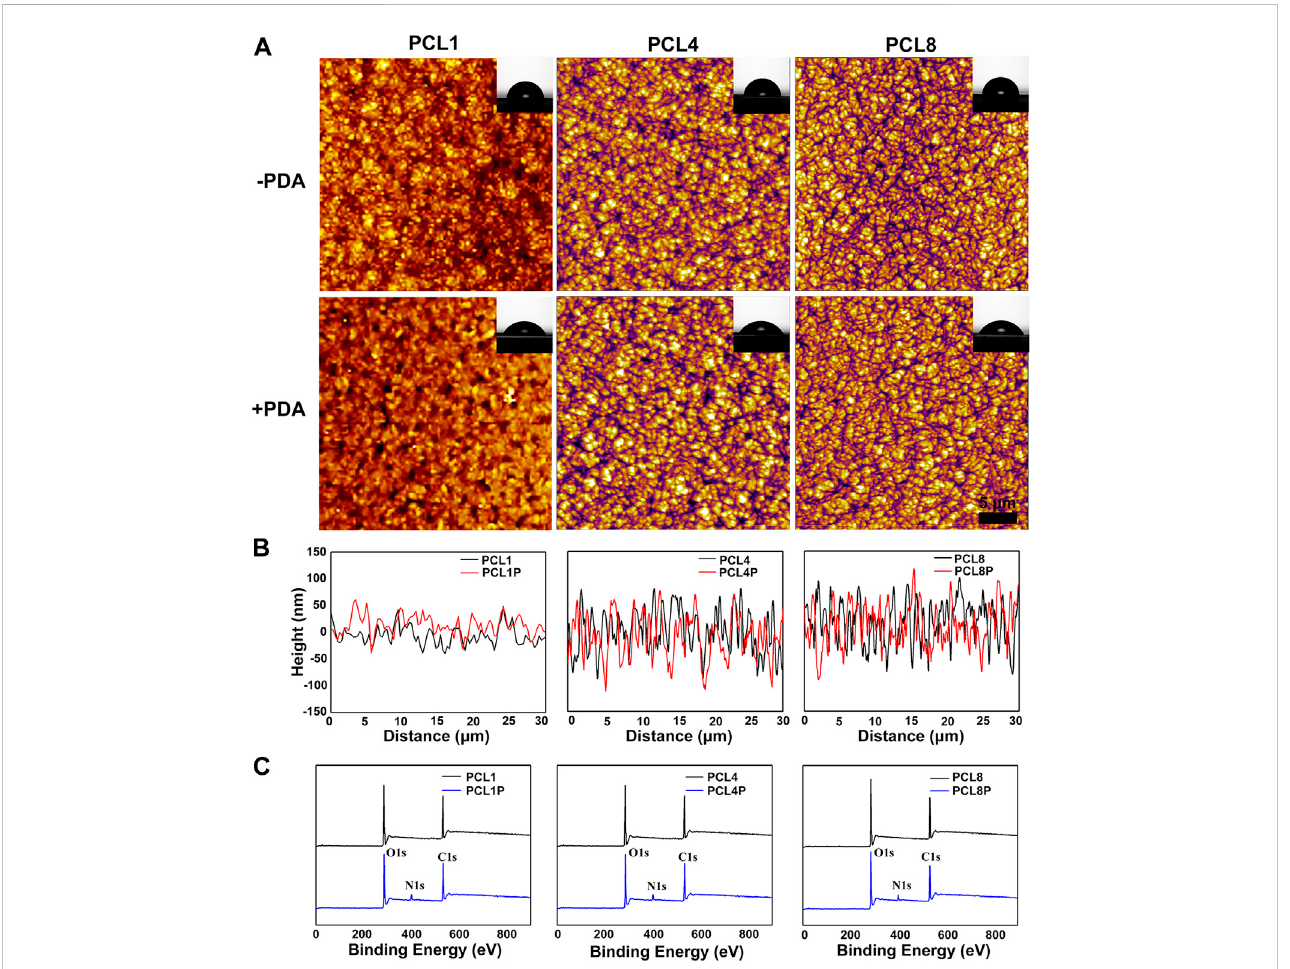
FIGURE 1 Characterization of nanoneedle arrays. (A) AFM images of nanoneedle arrays, the inset images show the corresponding water contact angles. (B) The height of nanoneedle arrays. (C) Survey XPS spectra determined on different samples.